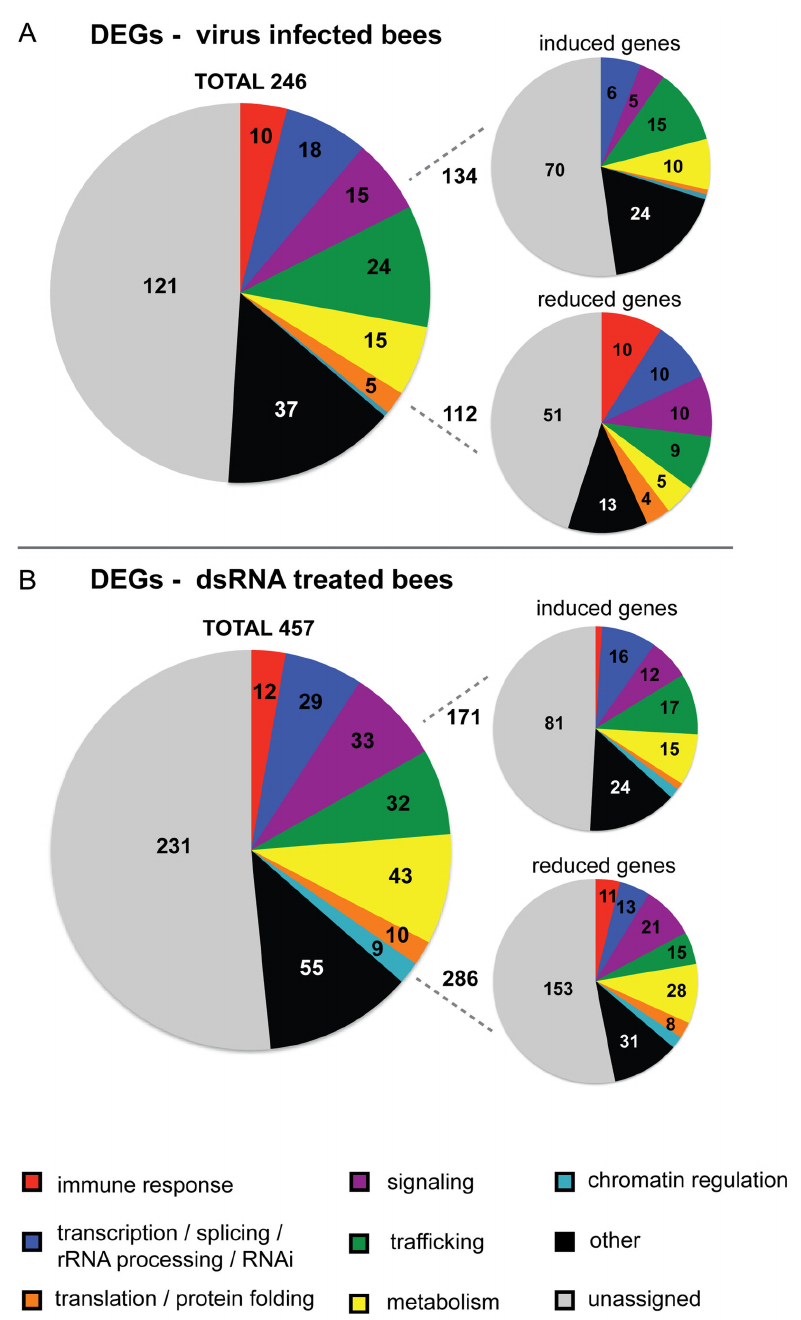
Figure 4. Gene Ontology analysis demonstrated reduced expression of immune genes and perturbation of cell-signaling, trafficking, and metabolism. Differentially expressed genes (DEGs, adj. p-value < 0.05) in (A) virus-infected or (B) dsRNA-treated honey bees as compared to mock-infected bees were assigned gene ontology terms for biological process, molecular function, and cellular compartment (see Tables S3-4). Biological process assignments were further categorized into seven functional groups: immune response (red); transcription, splicing, rRNA processing and RNAi (blue); signaling (purple); trafficking (green); metabolism (yellow); translation and protein folding (orange); and chromatin regulation (teal). A small fraction of the DEGs (10-15%) belonged to other biological process gene ontologies (black) and a large fraction was not assigned (gray). Each pie chart represents 100% of the DEGs and gene numbers are reported in each section. *Each oligonucleotide pair was analyzed as a single gene and since multiple microarray probes corresponded to apidaecin variants the majority of annotated immune effectors in this Figure (7 of 10 in virus- infected bees and 8 of 12 in dsRNA) correspond with apidaecin 1. doi: 10.1371/journal.pone.0077263.g004 PLOS ONE |